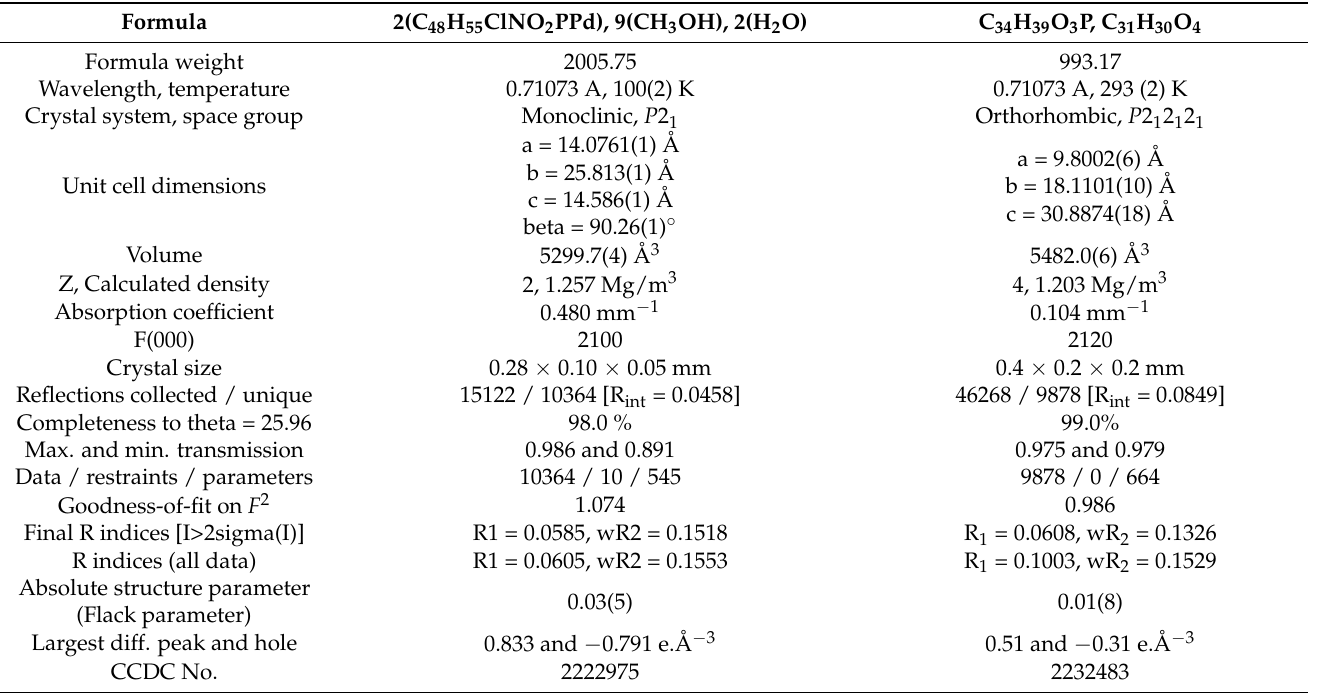
Table 18. Crystal data and structure refinement for Pd complex and cocrystal of 9 with TADDOL.